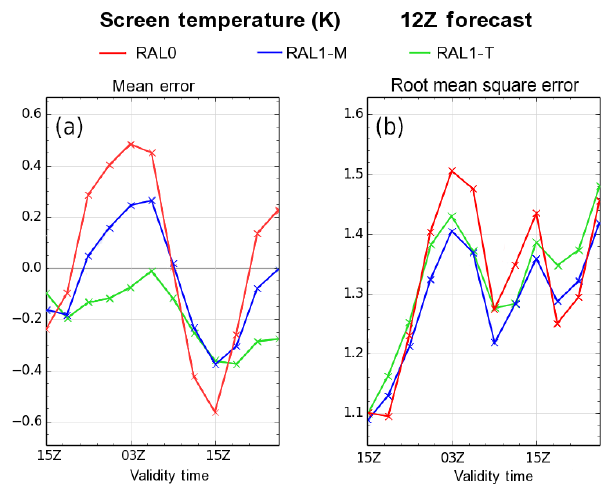
Figure 6. Case studies: diurnal cycle of screen temperature bias (a) and RMSE (b) for 12:00Z forecasts. RAL0 (red), RAL1-M (blue) and RAL1-T